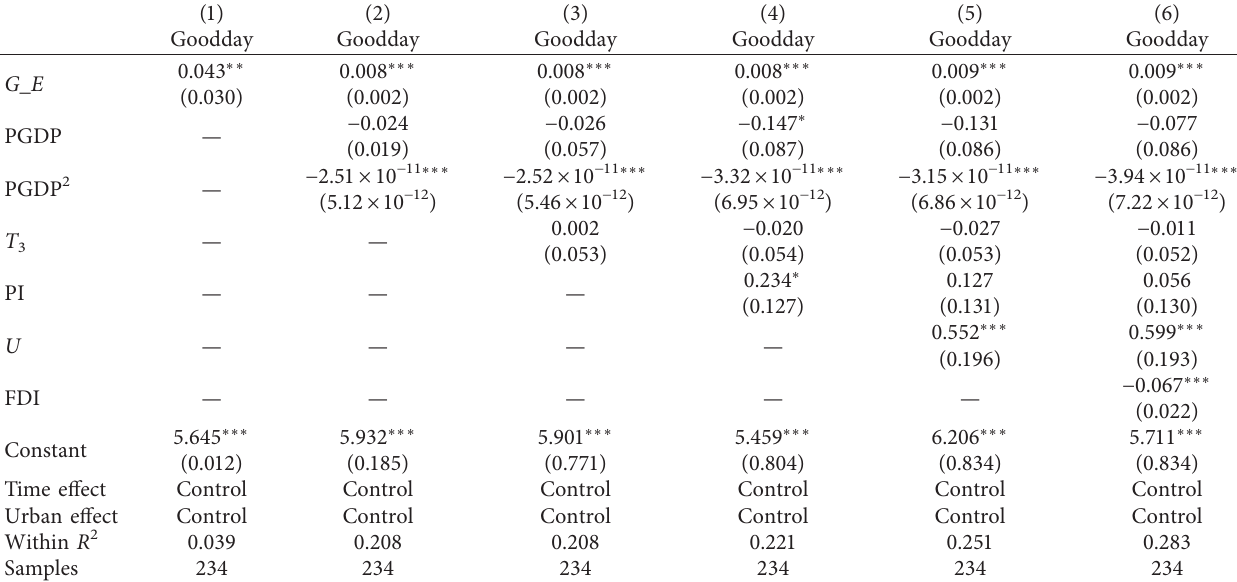
Table 6: Inspection of impact mechanism using rural electricity consumption